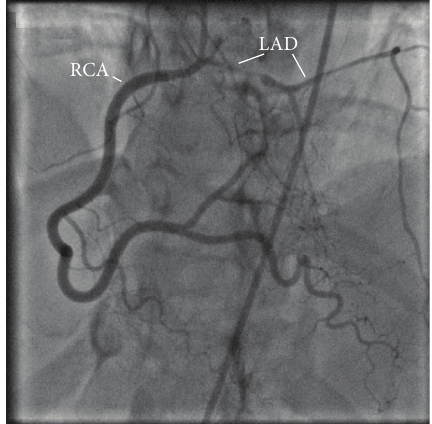
Figure 3: LAO cranial view of the RCA. Origin of the LAD artery from the ostium of the RCA can be seen, along with severe stenosis of the proximal portion of the LAD artery. The distal LAD artery with septal branches can also be seen.